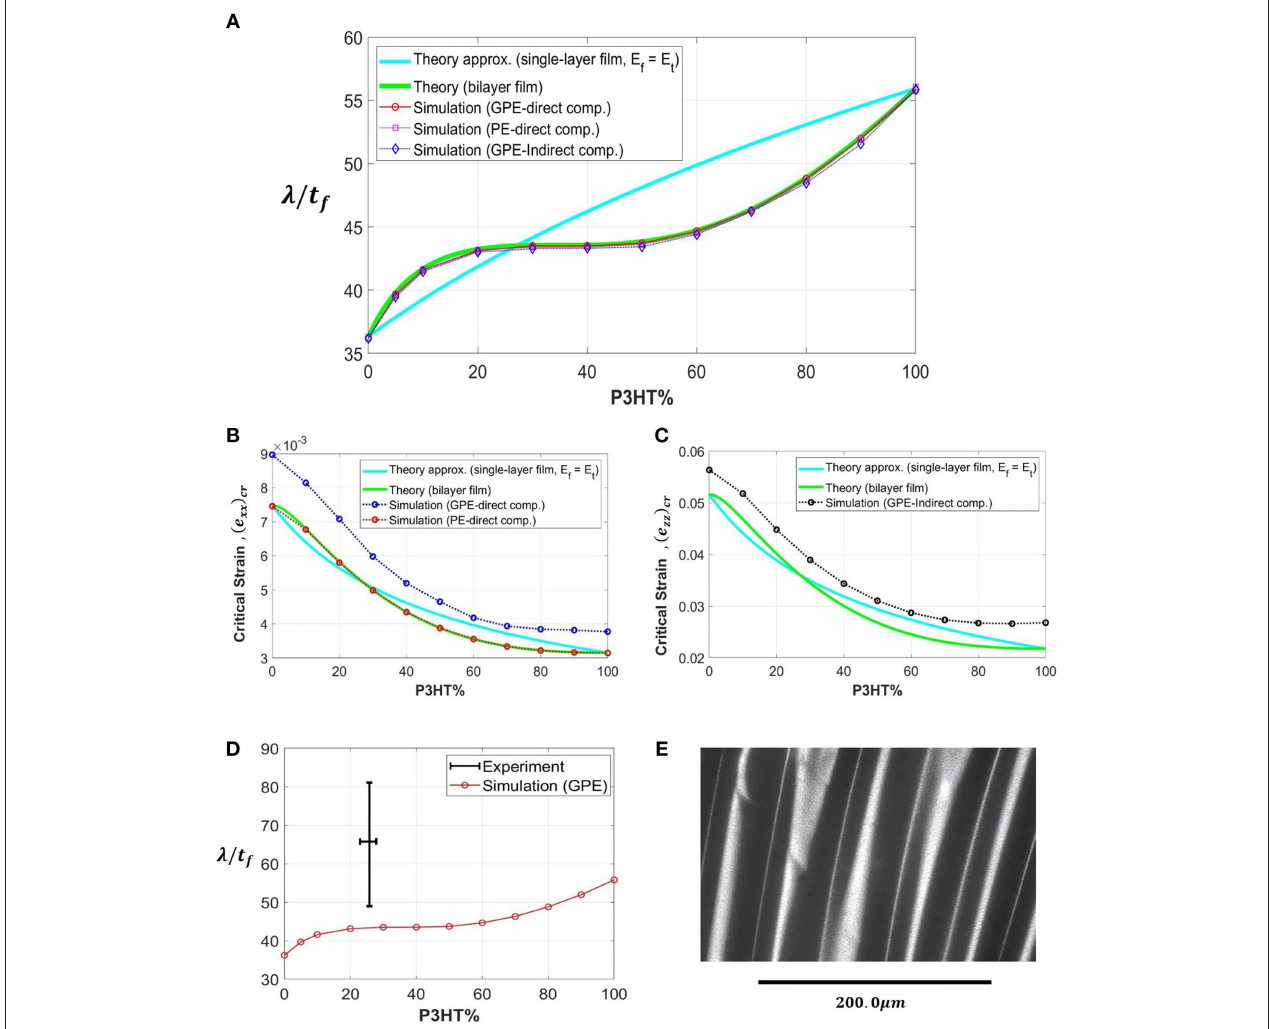
FIGURE 5 | (A) Variation of the simulated wrinkling wavelength normalized by film’s total thickness ( λ/ t f ), with the fractional volume percentage of the P3HT:PCBM film, for the cases of generalized plane strain (GPE) direct compression, plane strain (PE) direct compression, and indirect compression (GPE). The theoretical solutions are also included for comparison. (B,C) Variations of the simulated critical buckling strain with the fractional volume percentage of P3HT:PCBM film, for the cases of (B) direct compression and (C) indirect compression. The theoretical solutions are also included. (D) Comparison of an experimentally measured range of wavelengths and numerical predictions. (E) An optical microscopic image showing the surface wrinkles of a bilayer system of P3HT:PCBM/PEDOT:PSS films on the PDMS substrate.